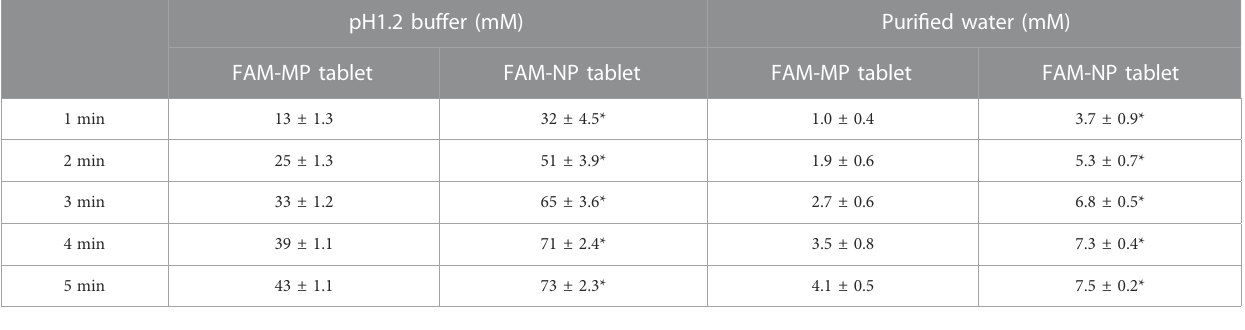
TABLE 3 The FAM-MP, and FAM-NP tablets (Rp.9 formulation) shown in Table 1 were used in this study (n = 3). * p < 0.05 vs. FAM-MP tablet for each category.